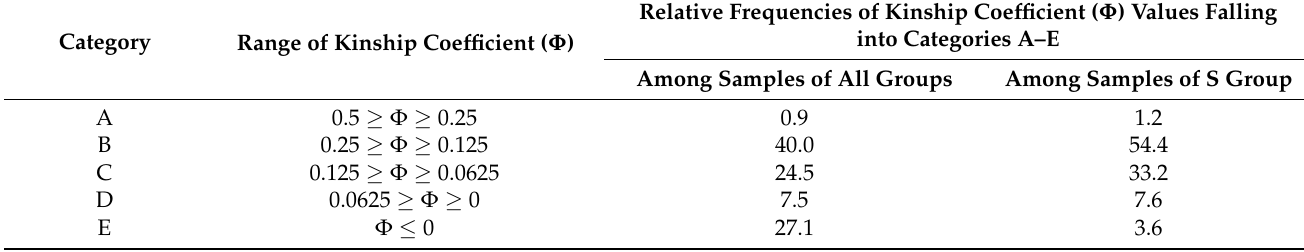
Table 5. Relative frequencies of relationship values between P. cactorum isolates categorised into five classes. The threshold values of Φ are matched to relations: 0.5—monozygotic twin or clone, 0.25—parent–offspring/full sibs, 0.125—2nd degree, such as half-sibs, 0.0625—3rd degree, such as first cousins, 0.0—unrelated, negative values indicate distinct